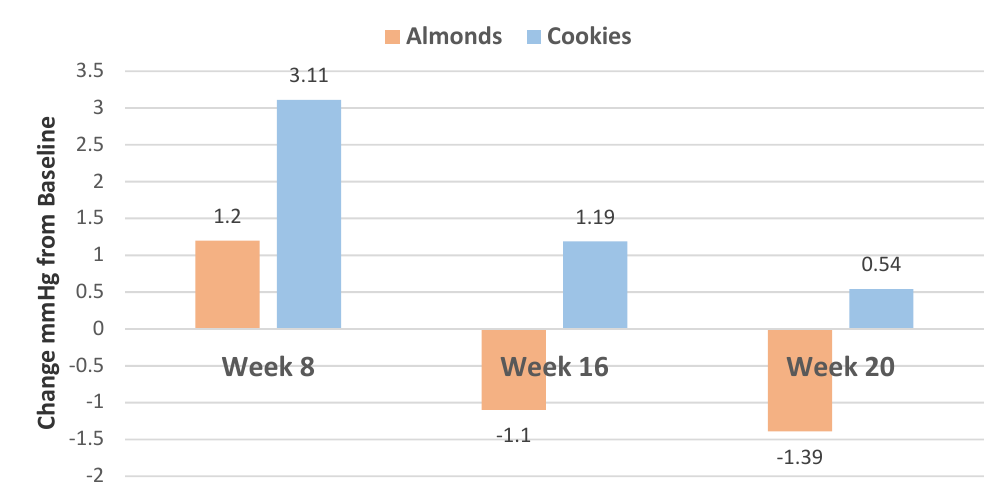
Figure 22. Effect of almond and cookie snacking on diastolic BP over time (almonds p -trend = 0.012 and control cookies p -trend = 0.135) [43].